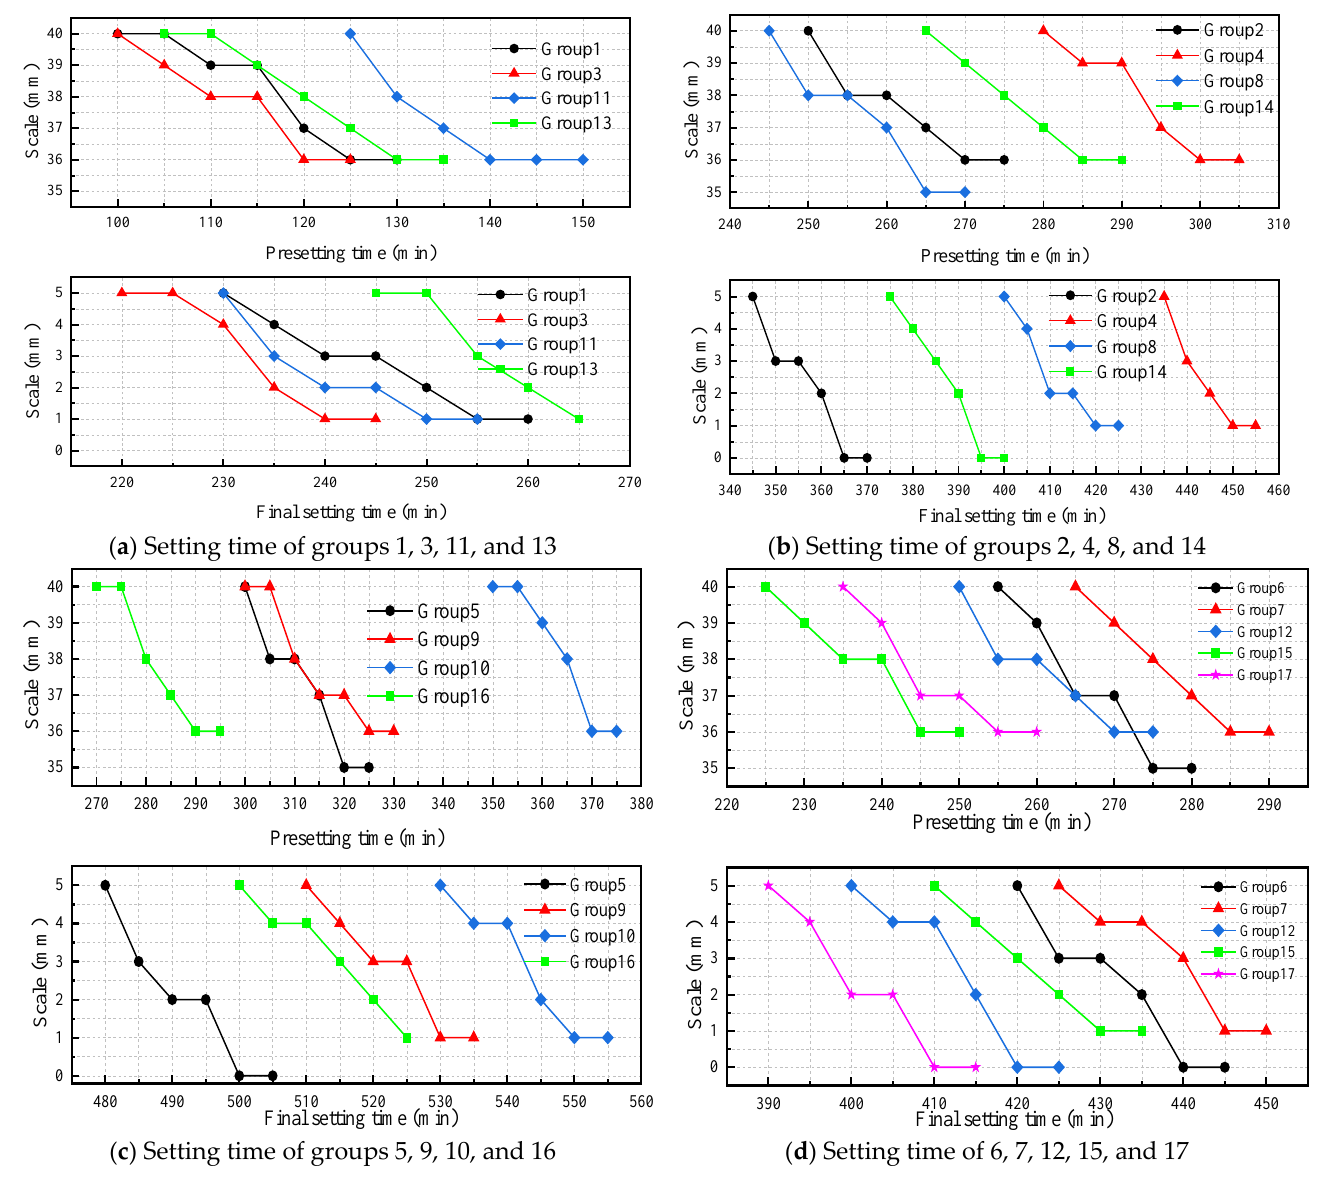
Figure 4. Setting time of the slurry with different components. ( a ) Setting time of groups 1, 3, 11, and 13; ( b ) Setting time of groups 2, 4, 8, and 14; ( c ) Setting time of groups 5, 9, 10, and 16; ( d ) Setting time of 6, 7, 12, 15, and 17.